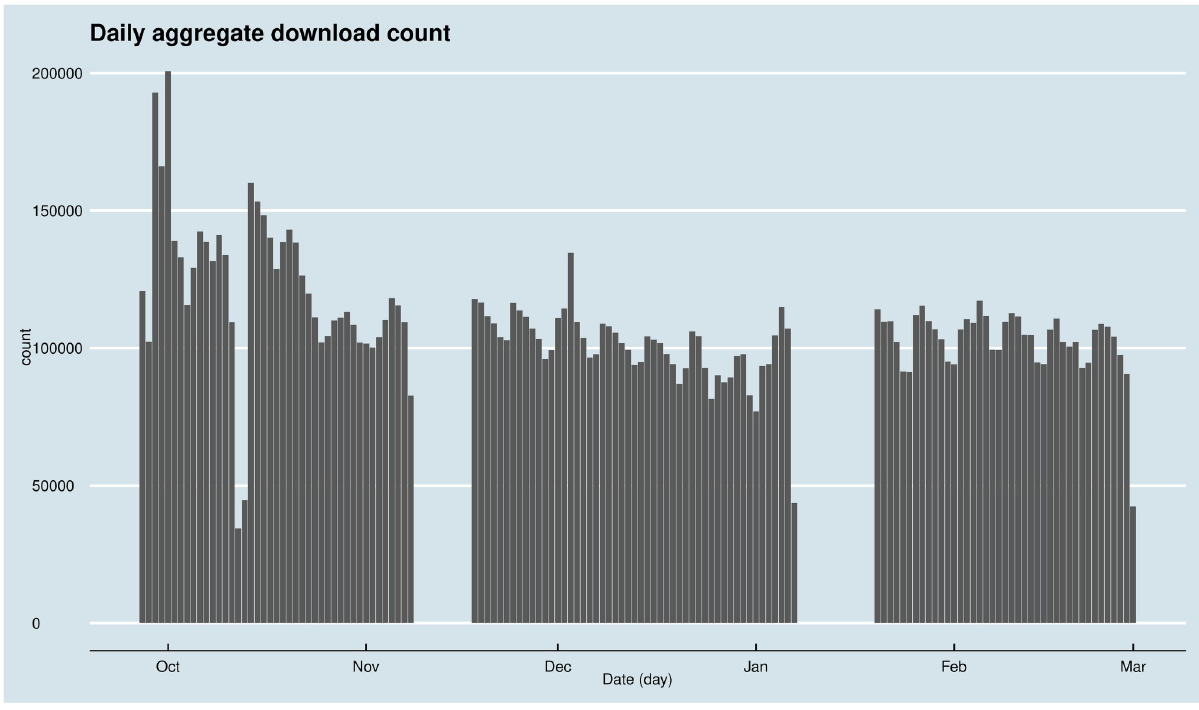
Fig 1. Daily aggregate download volumes.